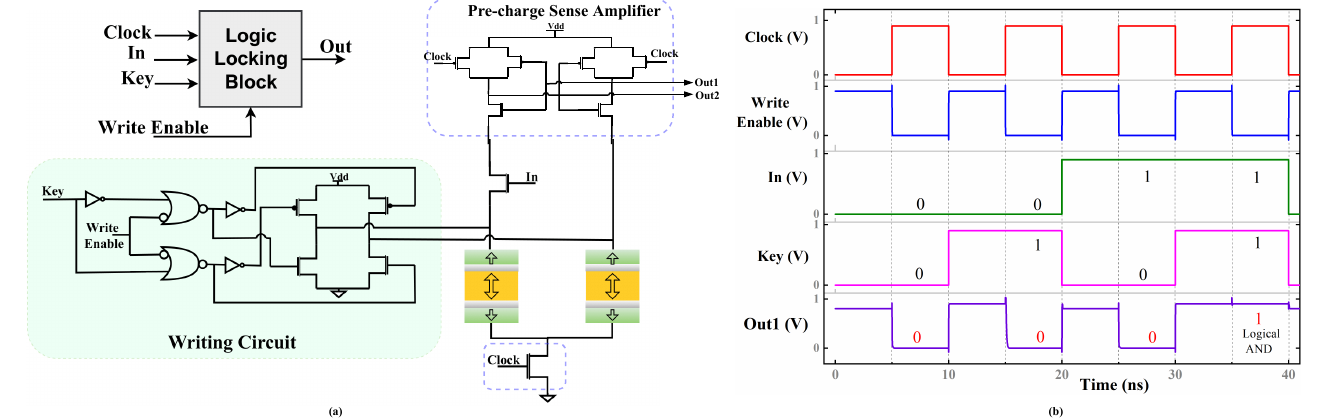
Figure 3. ( a ) Circuit and block diagram based on s-PMA DMTJ for LL mechanism; ( b ) output waveform for LL block performing AND